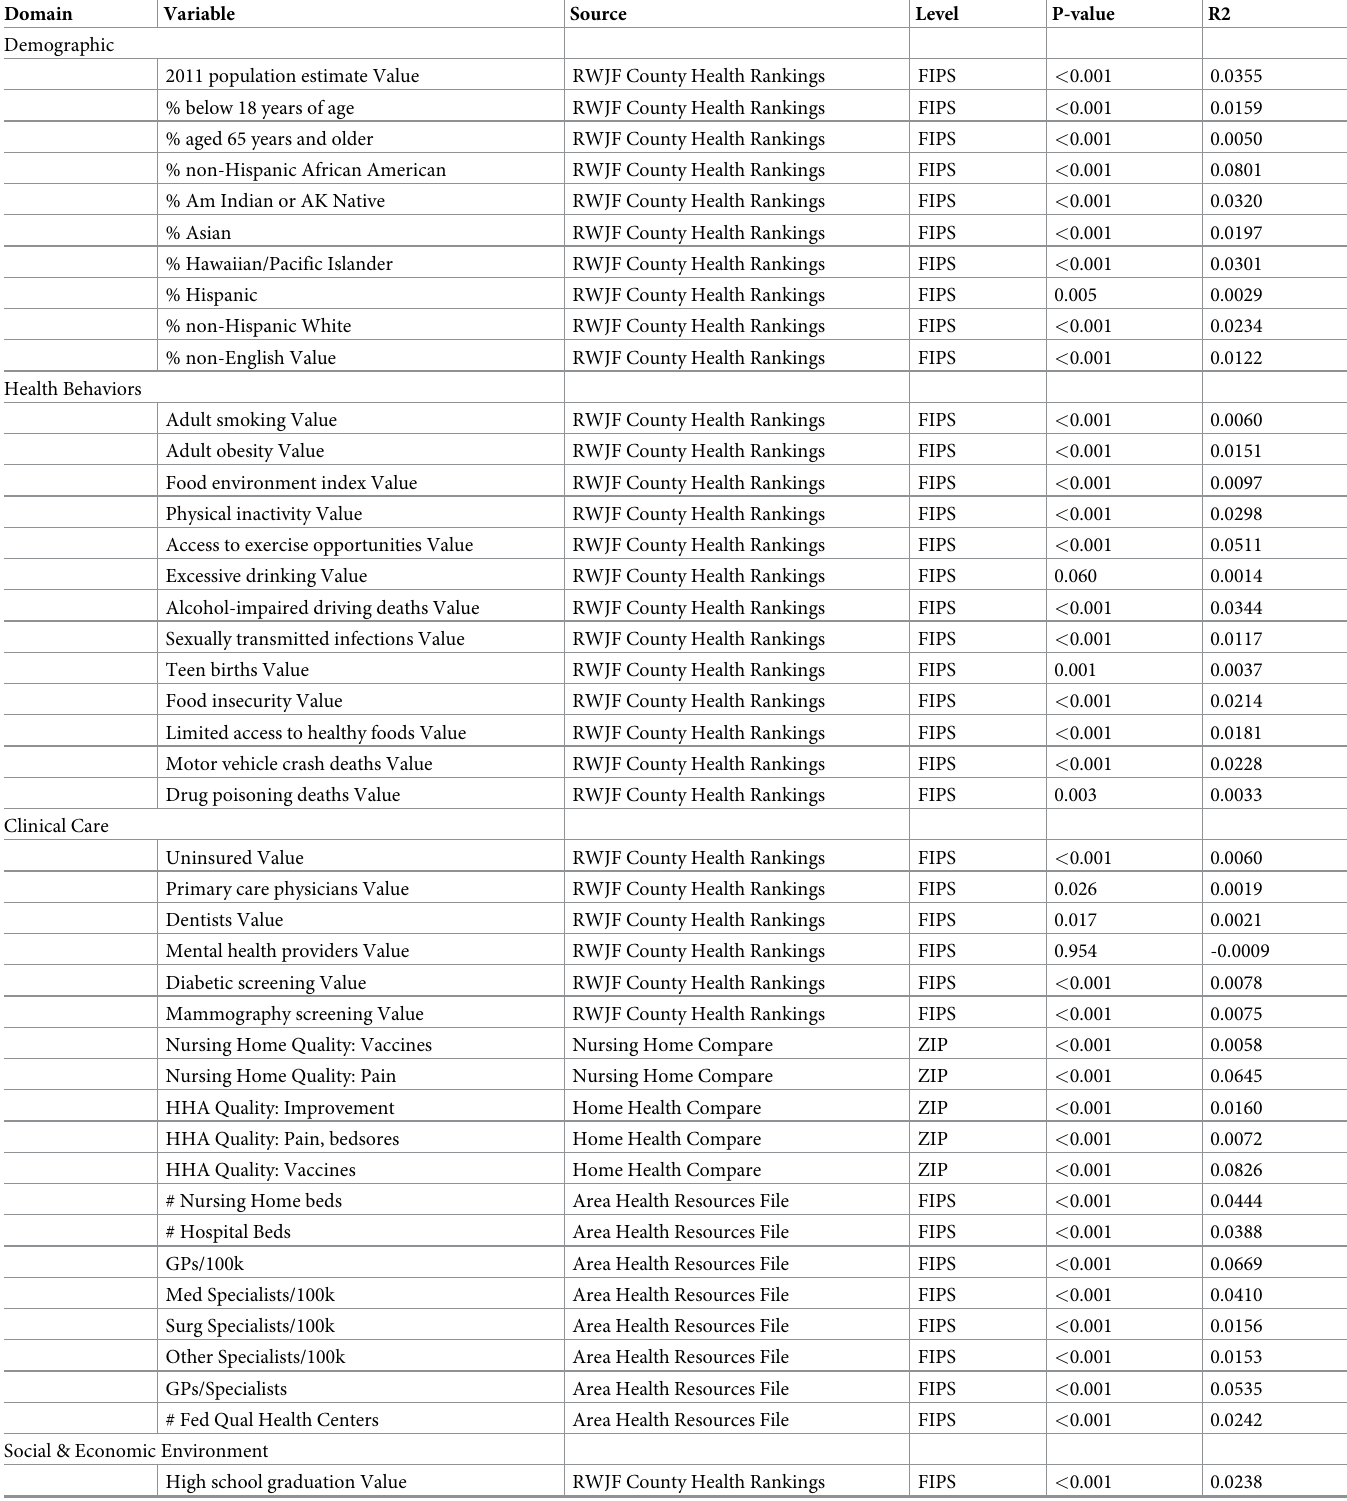
Table 1. Variables included in study, by